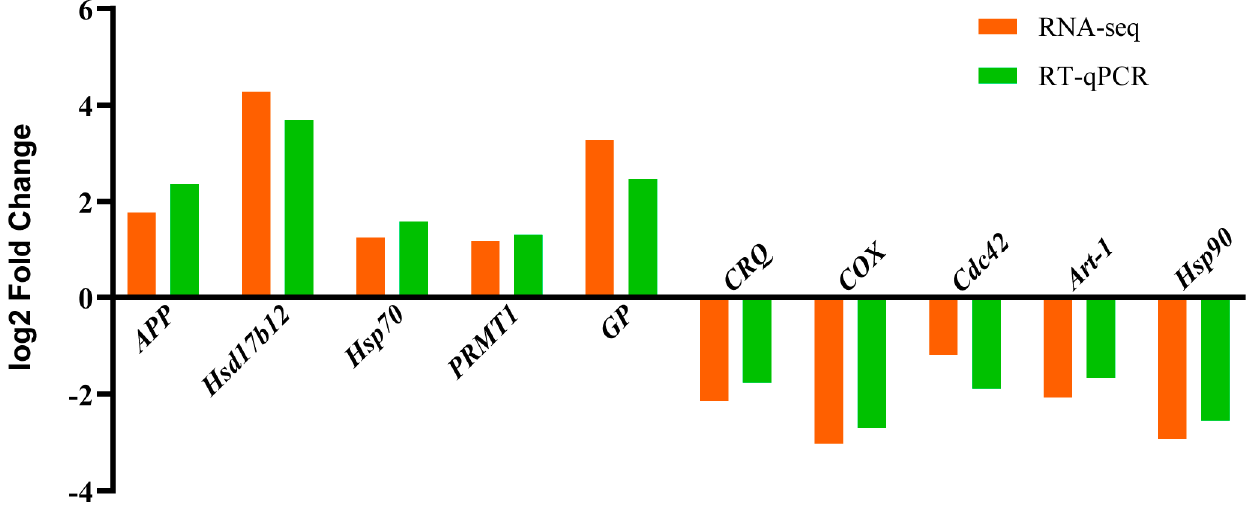
Figure 9. Validation of DEGs by RT-qPCR.